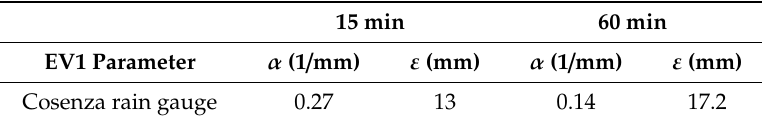
Table 4. EV1 parameters for AMR series of Cosenza rain